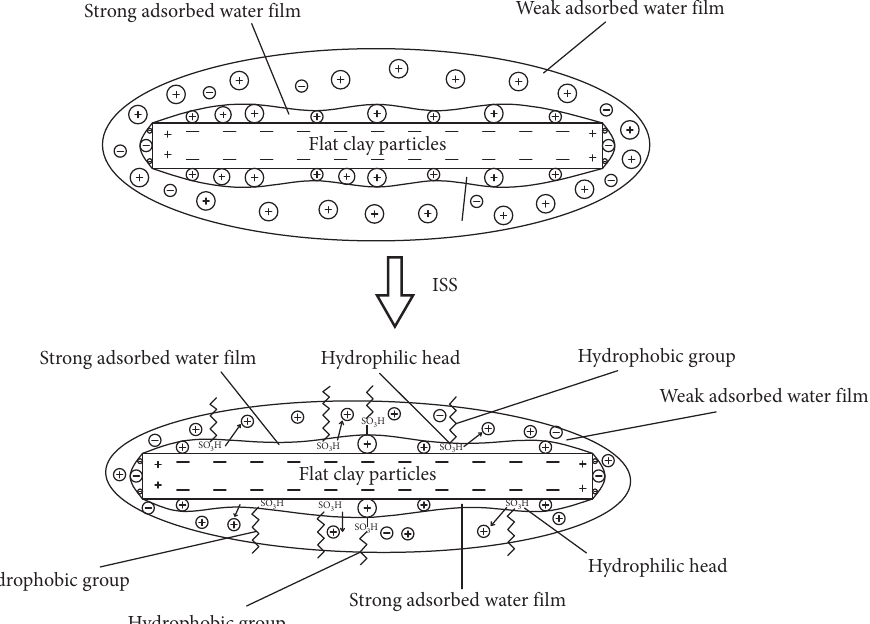
Figure 6: Schematic diagram of the interaction between ISS and clay